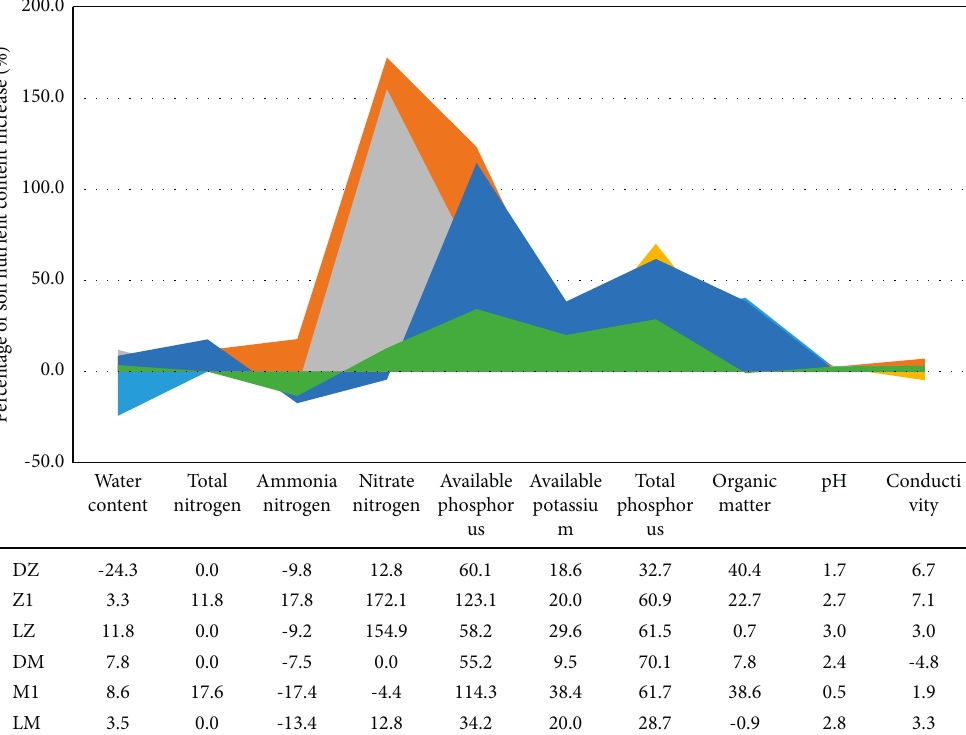
Figure 10: Effect of biomass improvement scheme on physical and chemical indexes of soil.